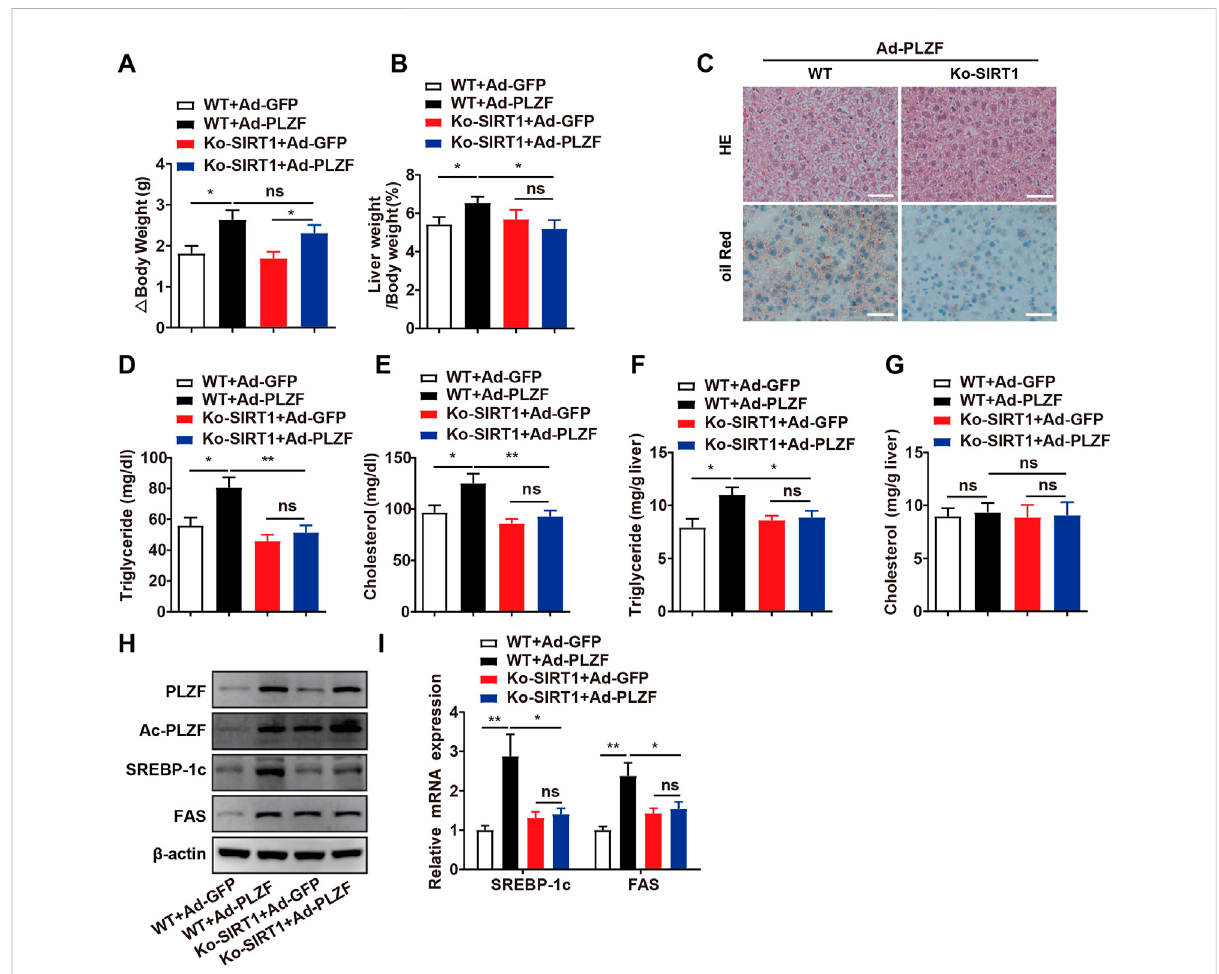
FIGURE 5 Hepatic SIRT1 knockout impedes PLZF-induced hepatic steatosis. Male C57BL/6J mice or Ko-SIRT1 mice were injected with Ad-GFP or Ad- PLZF adenovirus and then were sacri fi ced for further analysis. Depicted are (A) body weight change, (B) liver weight to body weight ratio, liver sections stained with (C) H and E (top panel) and Oil Red O (bottom panel), (D) serum TG, (E) serum cholesterol, (F) hepatic TG, (G) hepatic cholesterol, (H) acetylation levels of PLZF. (I) SREBP-1c and Fas in livers of mice that were treated with the indicated adenovirus were analyzed by qPCR. N = 6 – 8/group. For adenovirus injection, mice were injected via their tail vein with adenovirus. Then, 5 – 7 days after infection, mice livers and plasma were collected for further analysis. The data shown are the means ± SEM. Scale bar, 50 μ m * p < 0.05, ** p <